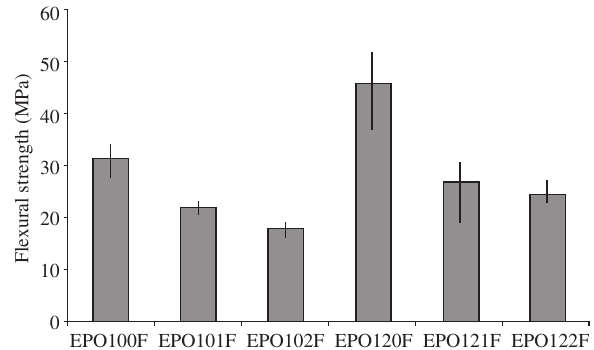
Figure 6. Compressive strength comparison of all polymer concrete for-